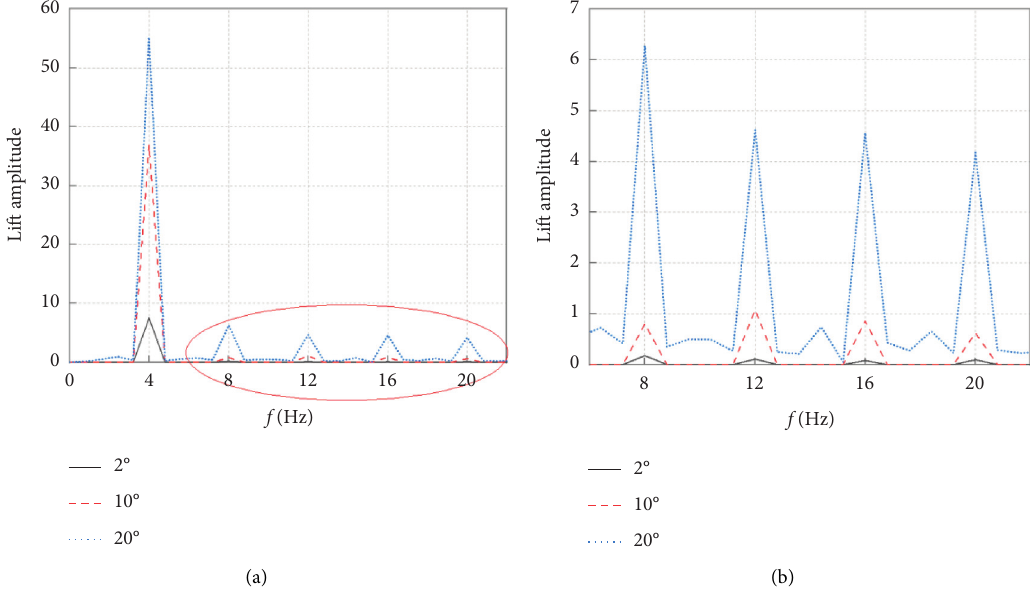
Figure 11: Aerodynamic lift spectrum under different torsional amplitude vibrations of the single frequency. (a) Complete spectrum. (b) Locally amplified